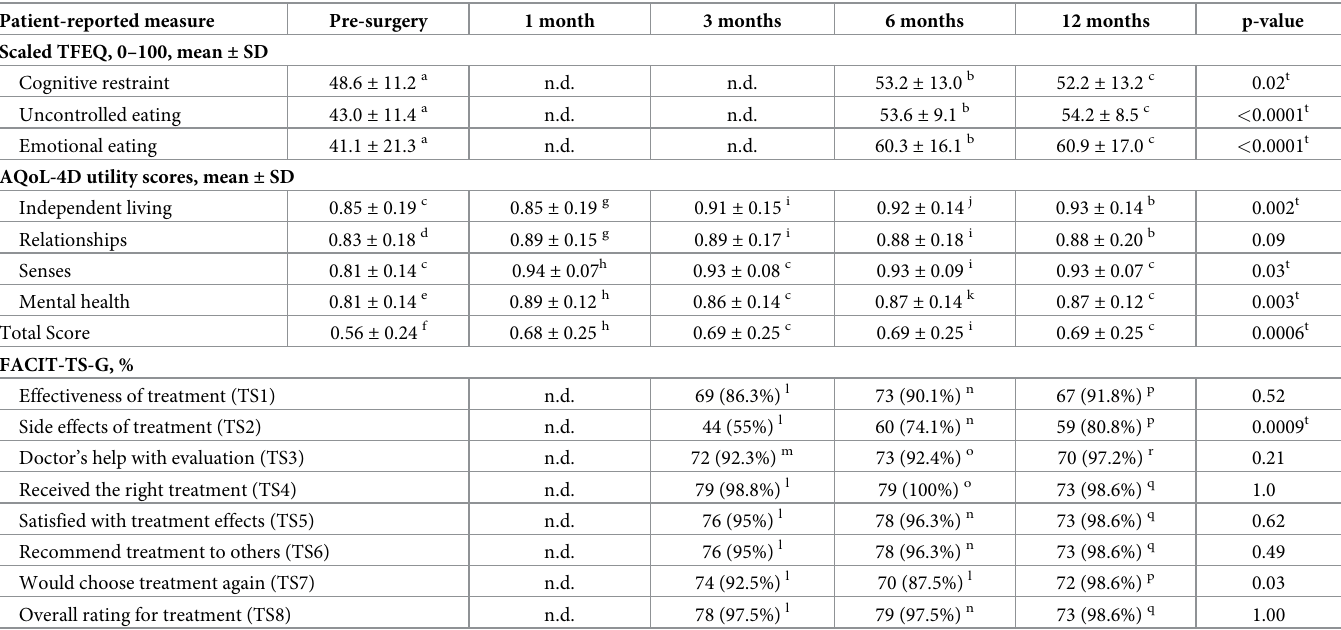
Table 2. Patient-reported outcomes and experiences following bariatric